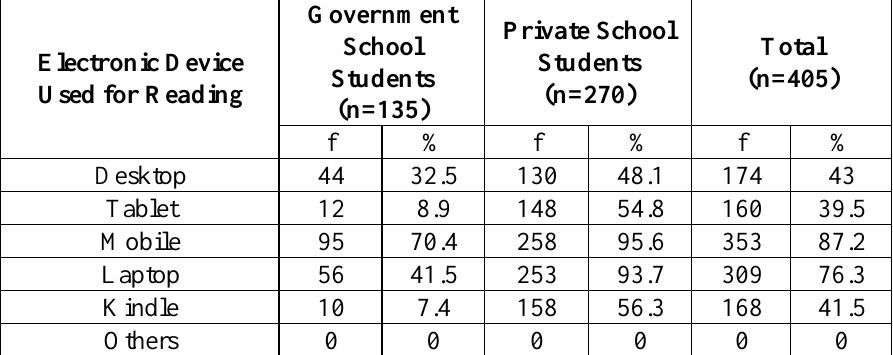
Table 7- Electronic Devices used for Reading by School Students